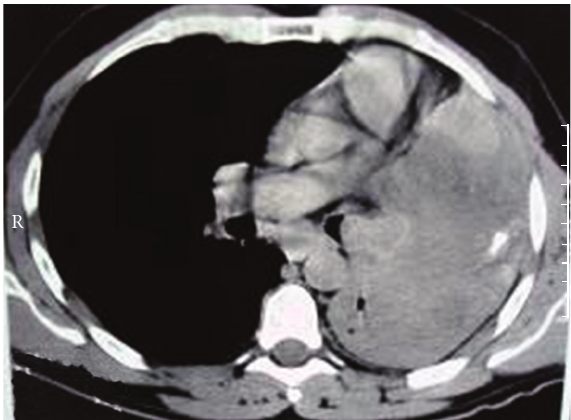
Figure 1: Tumor mass obstructing the left main bronchus.